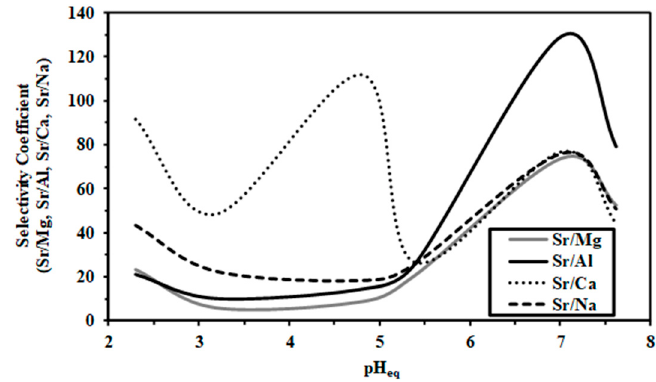
Figure 5. Effect of the pH on the selectivity coefficient for the separation of Sr(II) from Mg(II), Al(III), Ca(II), and Na(I) (equimolar solutions: C 0 = 1.8 mmol L − 1 ; SD: 125 mg L − 1 ; contact time: 48 h; agitation speed: 140 rpm: room temperature: 25 ± 1 °C).